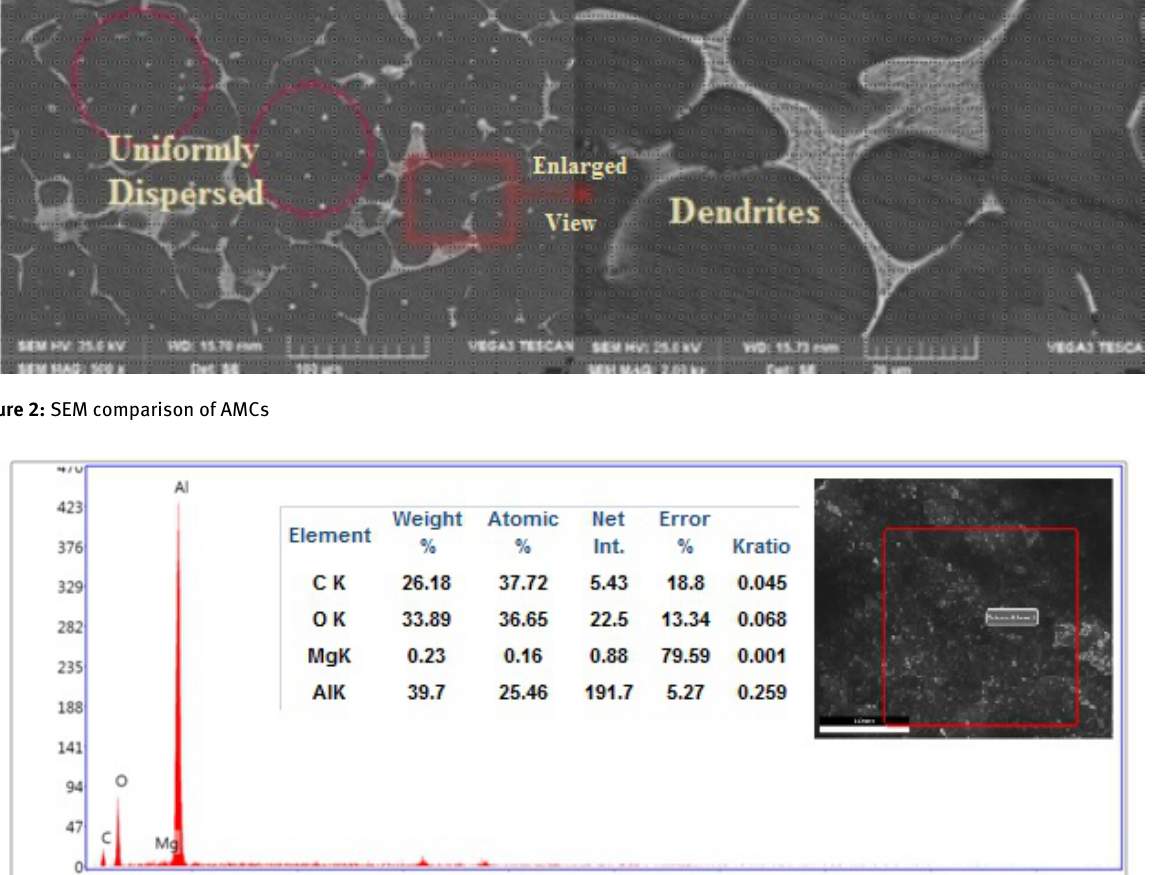
Figure 3: EDS image of 5% Al/Al 2 O 3